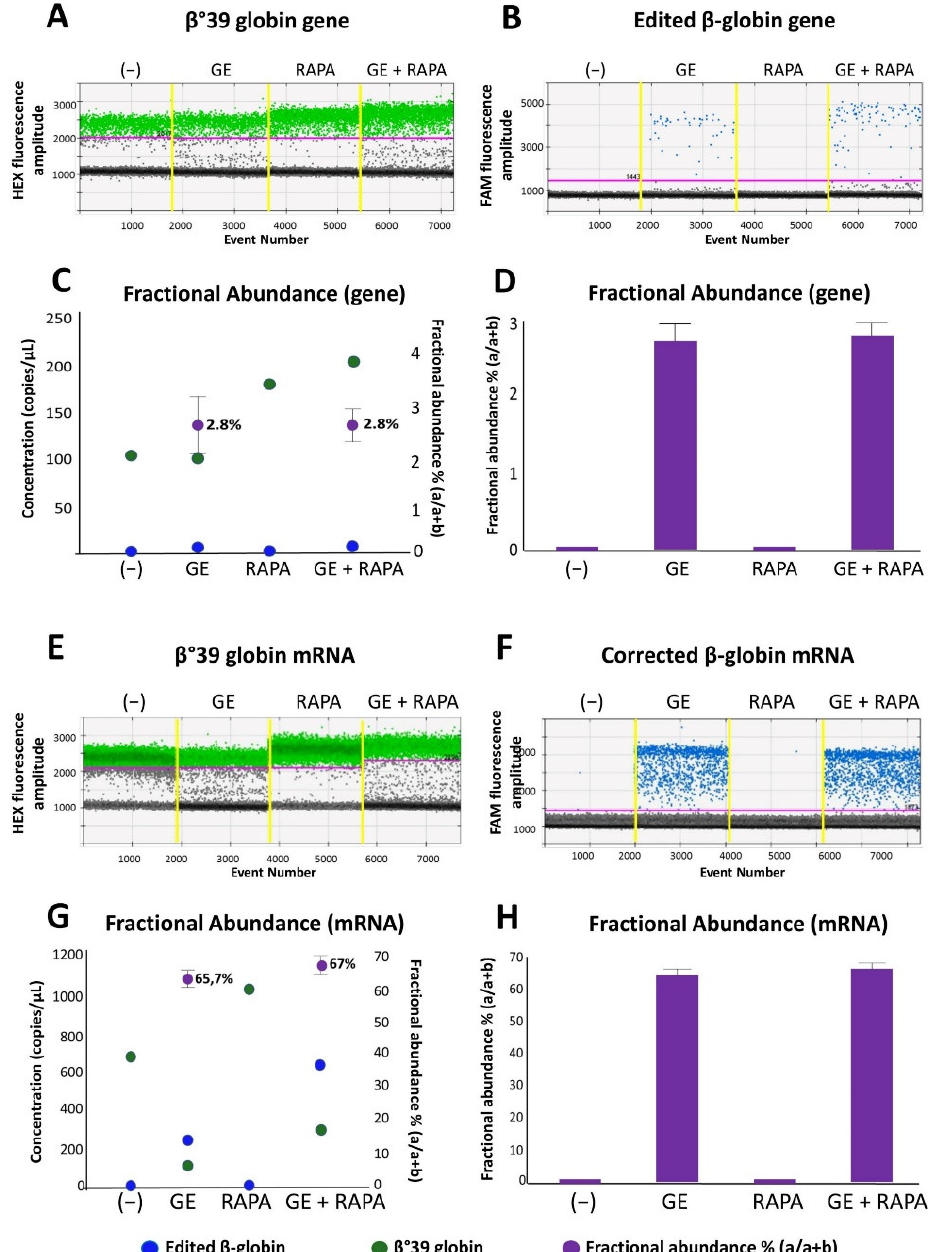
Figure 1. Evaluation of the effects of CRISPR-Cas9 system on β -globin gene and mRNA in ErPCs cultures. The panels show the data relating to a representative result obtained after gene correction treatments performed with the CRISPR-Cas9 system on a culture of β 0 39 ErPCs and analyzed with ddPCR assay. ( A , B ) and ( E , F ) refer to 1d dot plots obtained after analysis of mock treated ( A , E —green dots) and edited ( B , F —blue dots) β -globin gene and mRNA, respectively. ( C , G ) Correlation between the concentration of the samples (expressed in copies/ µ L) and the fractional abundance (purple dot) related to the representative example reported in panels ( A , B ) and ( E , F ). ( D , H ) Histograms extrapolated from the analysis of the fractional abundance of the representative sample used in the experiment. ( − ) control untreated cells; GE (cells treated with the CRISPR-Cas9 system), RAPA (rapamycin 200 nM) and GE + RAPA (cells treated with the CRISPR-Cas9 system and then cultured in the presence of rapamycin). As is clearly evident, the presence of amplified edited β -globin gene sequences is absent in control untreated ( − ) and in rapamycin-treated (RAPA) ErPCs but present